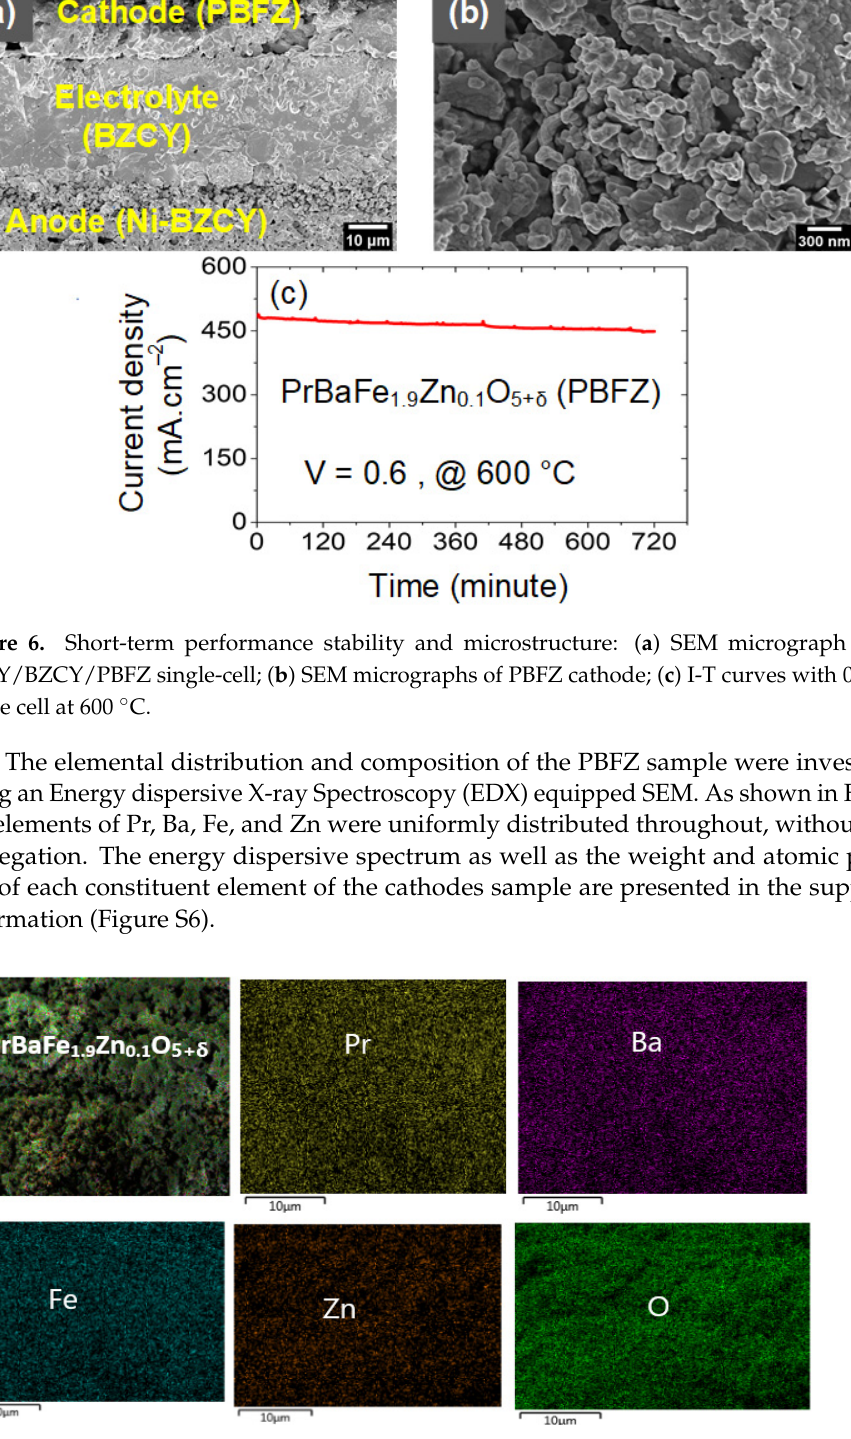
Figure 7. Elemental composition and distribution of PBFZ studied by EDX.